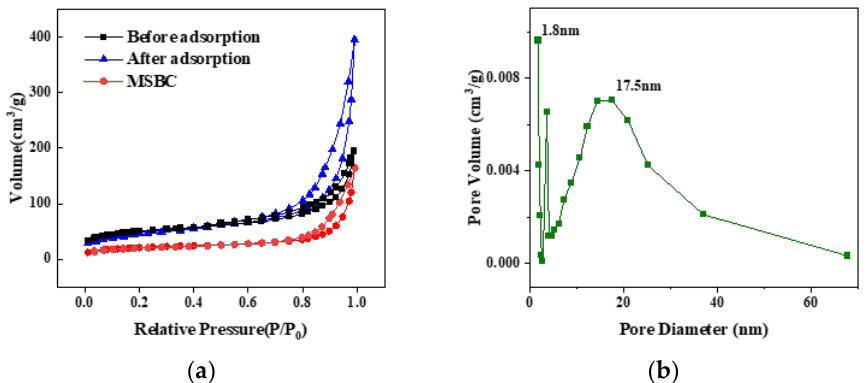
Figure 4. BET results for nZVZ–MSBC. ( a ) Nitrogen adsorption–desorption curve before and after adsorption and ( b ) pore size distribution curve.